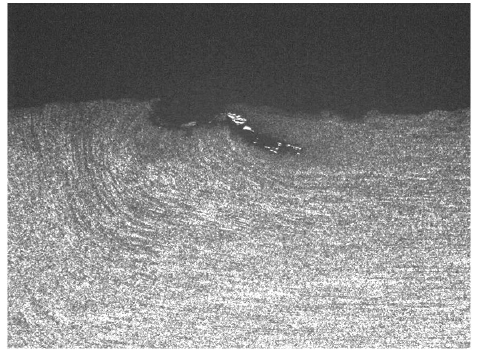
Figure 13. Rolling and folding on outer surface of 2# cracking pipe.